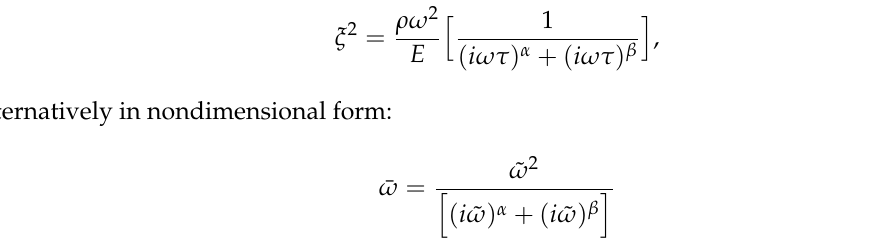
Figure 6. Here again we fix α = 0.5 and vary β . Different from fractional Maxwell model, centerline velocity profiles (Figure 6a,c,e) do not exhibit aperiodic oscillations with varying both fractional order and ˜ a . Centerline velocity amplitudes increase with increasing ˜ a and decrease with increasing fractional order β . Shear stresses’ dynamics for the same model are presented in Figure 6b,d,f. Here again all three types of behavior encountered for fractional Maxwell model are present. More specifically, as ˜ a increases, shear stresses experience three different types of behavior: from monotonically increasing through resonant to oscillatory. Relative stress amplitudes decrease with increasing fractional order β